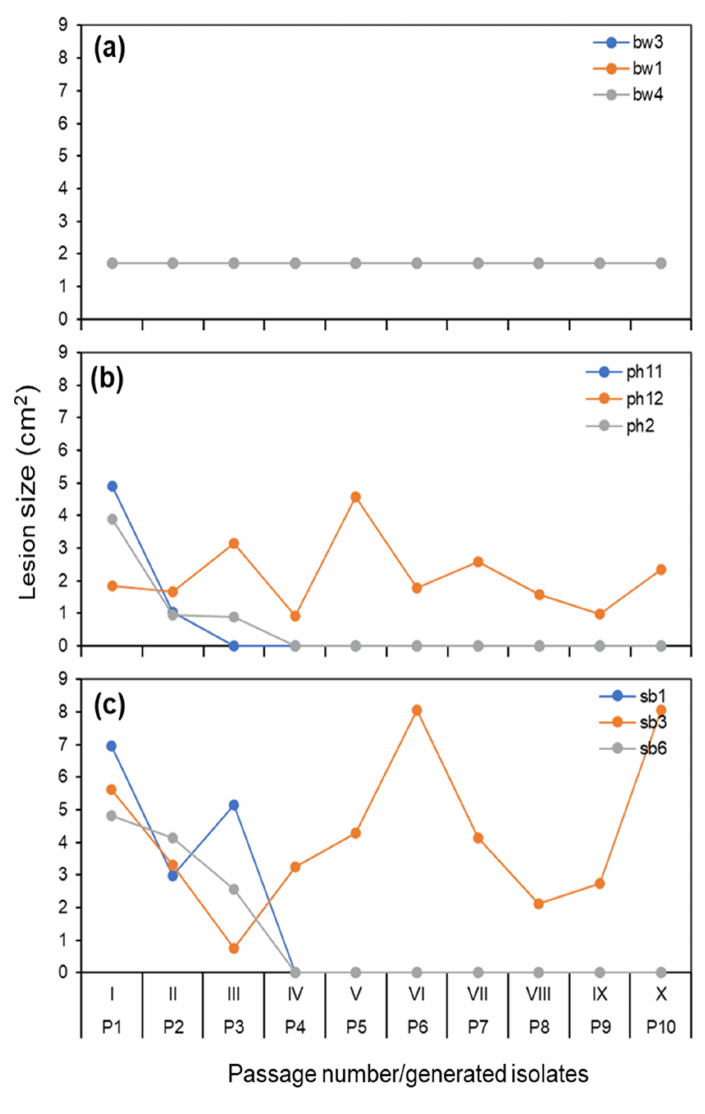
Figure 3. Blight lesion size caused by Calonectria pseudonaviculata isolates on their plants of origin, i.e., boxwood ( a ), pachysandra ( b ), or sweet box ( c ), 4 weeks after inoculation in 10 passages (I–X). The lines and dots of bw1 and bw3 are masked due to overlapping with bw4 in ( a ). For each isolate, detached leaves ( n = 10) of an original host plant were inoculated with a drop of conidial suspension from a culture plate (P0) for passage I or from infected leaves of the previous passage I to IX for passages II–X. P1–P10 are the isolates generated in the individual passages. Each point represents an average of lesion